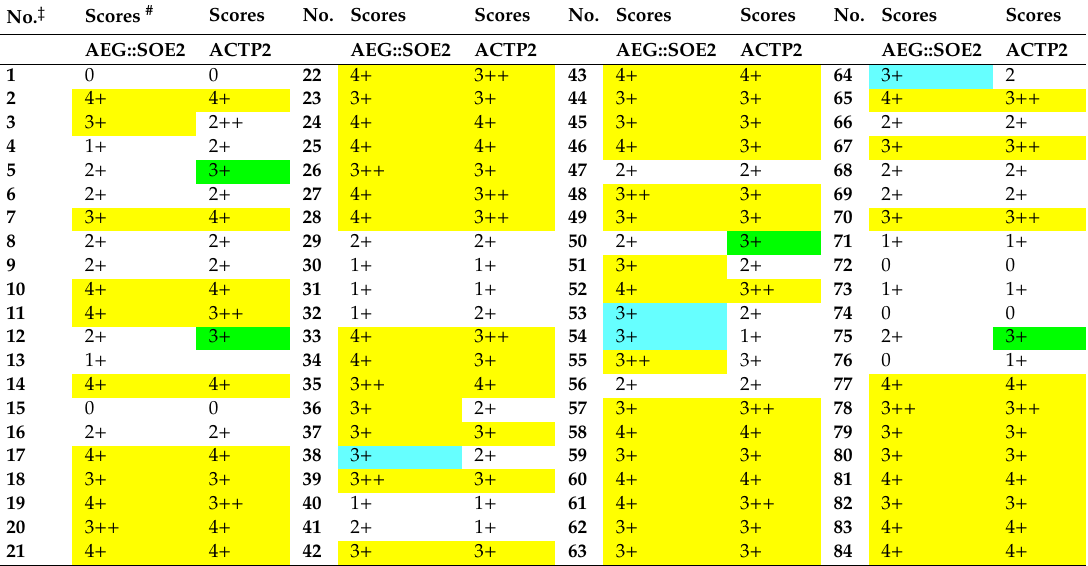
Table 3. Reactivities by ELISA using ACTP2 comparing with AEG::SOE2 as